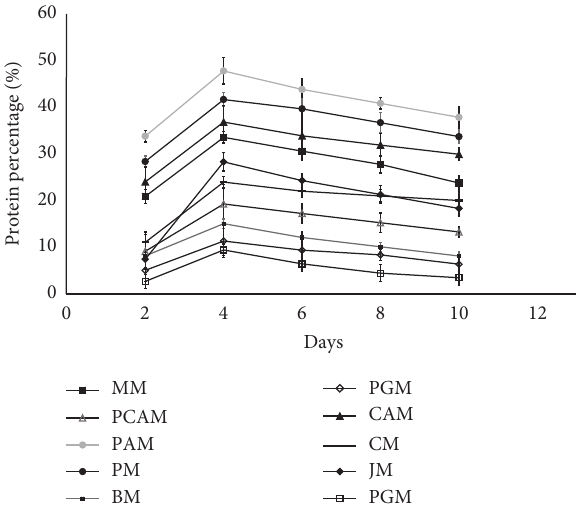
Figure 2: Protein content (%) of Bakers’ yeast biomass using various fruit wastes media in submerged fermentation at 100rpm on a time course basis. Each data point represents the mean- ± standard deviation ( n � 3, ∗ P ≤ 0 .